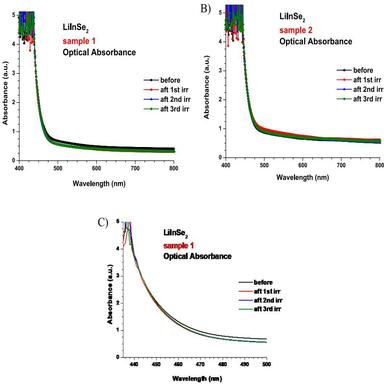
Optical absorption spectra of the two LiInSe2 samples before and after (aft) each irradiation (irr).